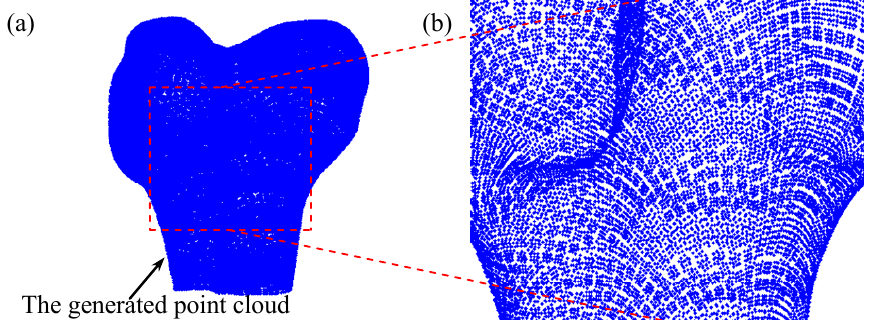
Figure 8. Chinese lion head model as an example of fitting T-splines, ( a ) the original lion head model, ( b ) the pre-image of T-meshes and triangle mesh vertexes, ( c ) the spatial distribution of control points and T-meshes.